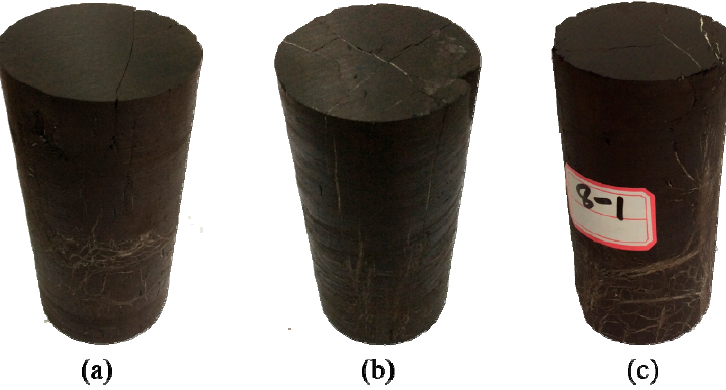
Figure 6. Visually-observed defects of coal specimens before triaxial tests: (a) σ 3 =1.0 MPa; (b) σ 3 =5.0 MPa; (c) σ 3 =6.0 MPa.